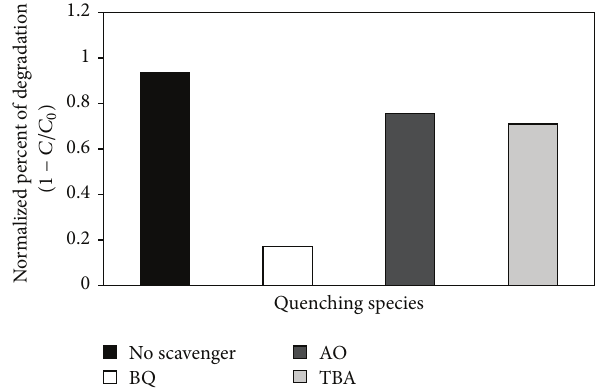
Figure 11: Quenching tests for photocatalytic degradation of RhB on BiVO 4 (C+H-200-24) under different conditions with